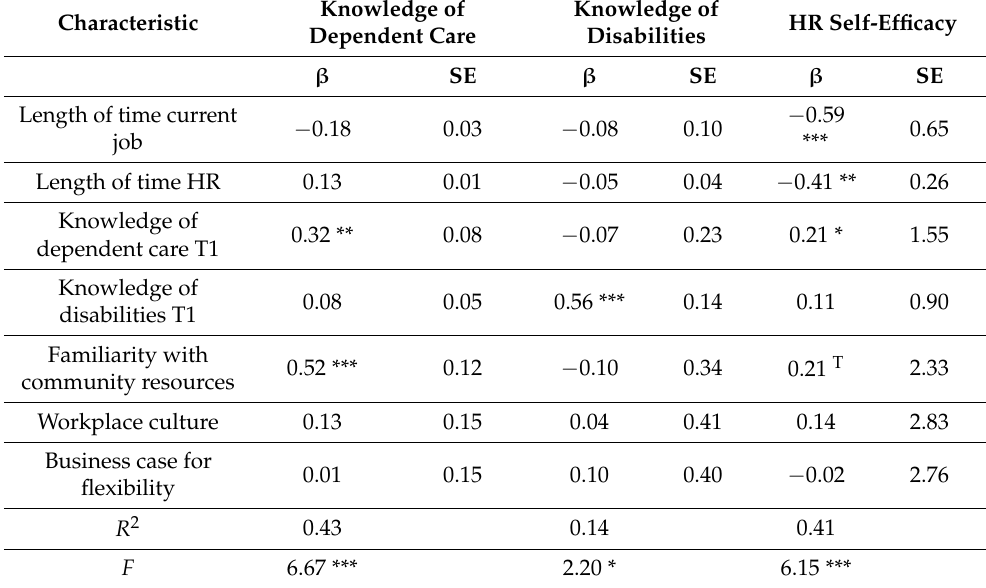
Table 4. Simultaneous regression models of HR characteristics predicting training outcomes.